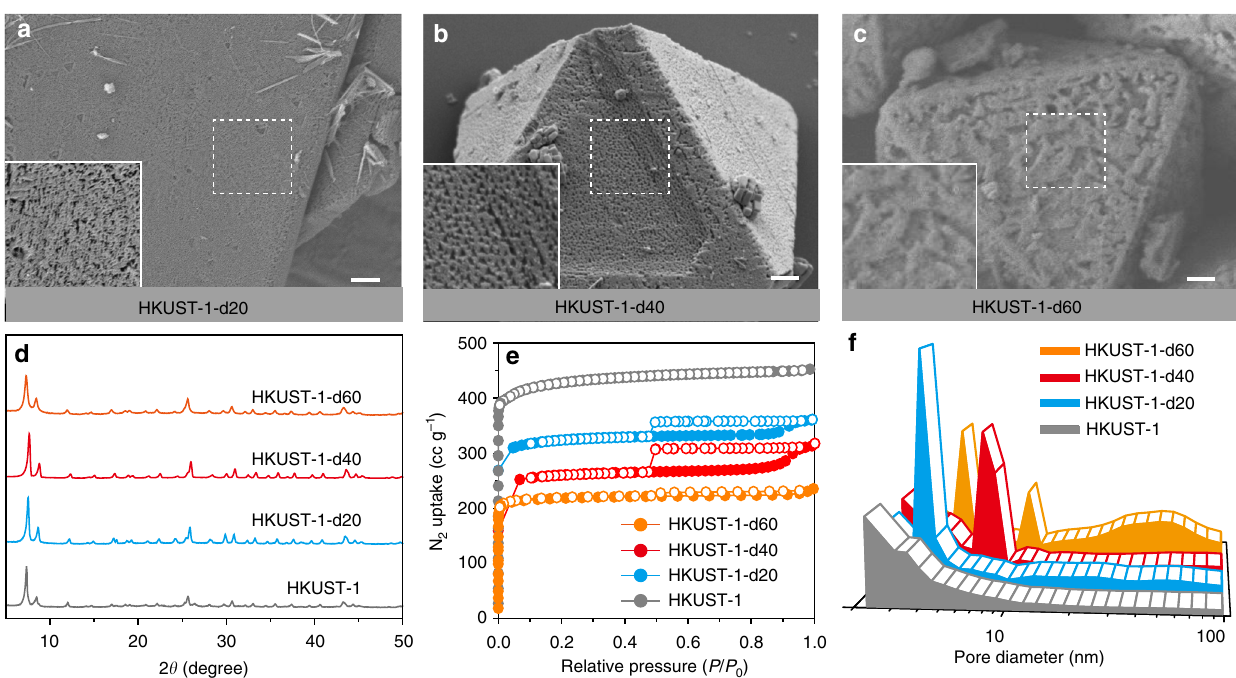
Fig. 2 Development of the meso- and macro-pores within HKUST-1 via decarboxylation at 120 °C. The product of the decarboxylation process was examined every 20 min up to 60 min of residence time. SEM images of a HKUST-1-d20, b HKUST-1-d40, and c HKUST-1-d60 (scale bar is 1 µ m), d X-ray diffraction patterns, e N 2 sorption isotherms, and f BJH pore-size distribution of HKUST-1, HKUST-1-d20, -d40, and